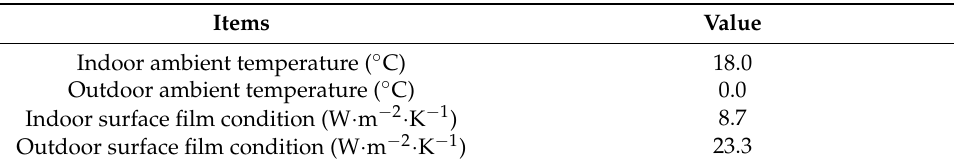
Table 3. Simulation parameter